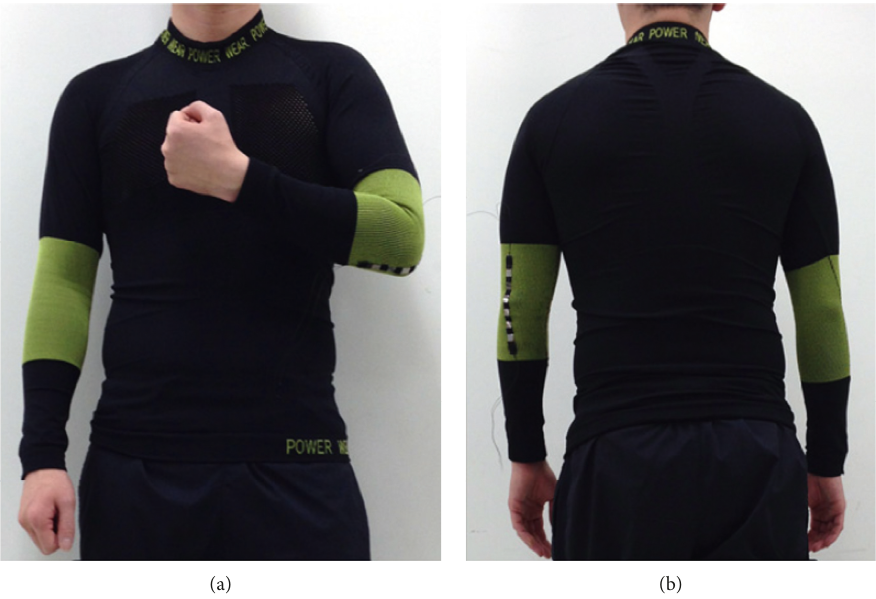
Figure 3: A view of the garment with a piezoelectric element at the elbow line